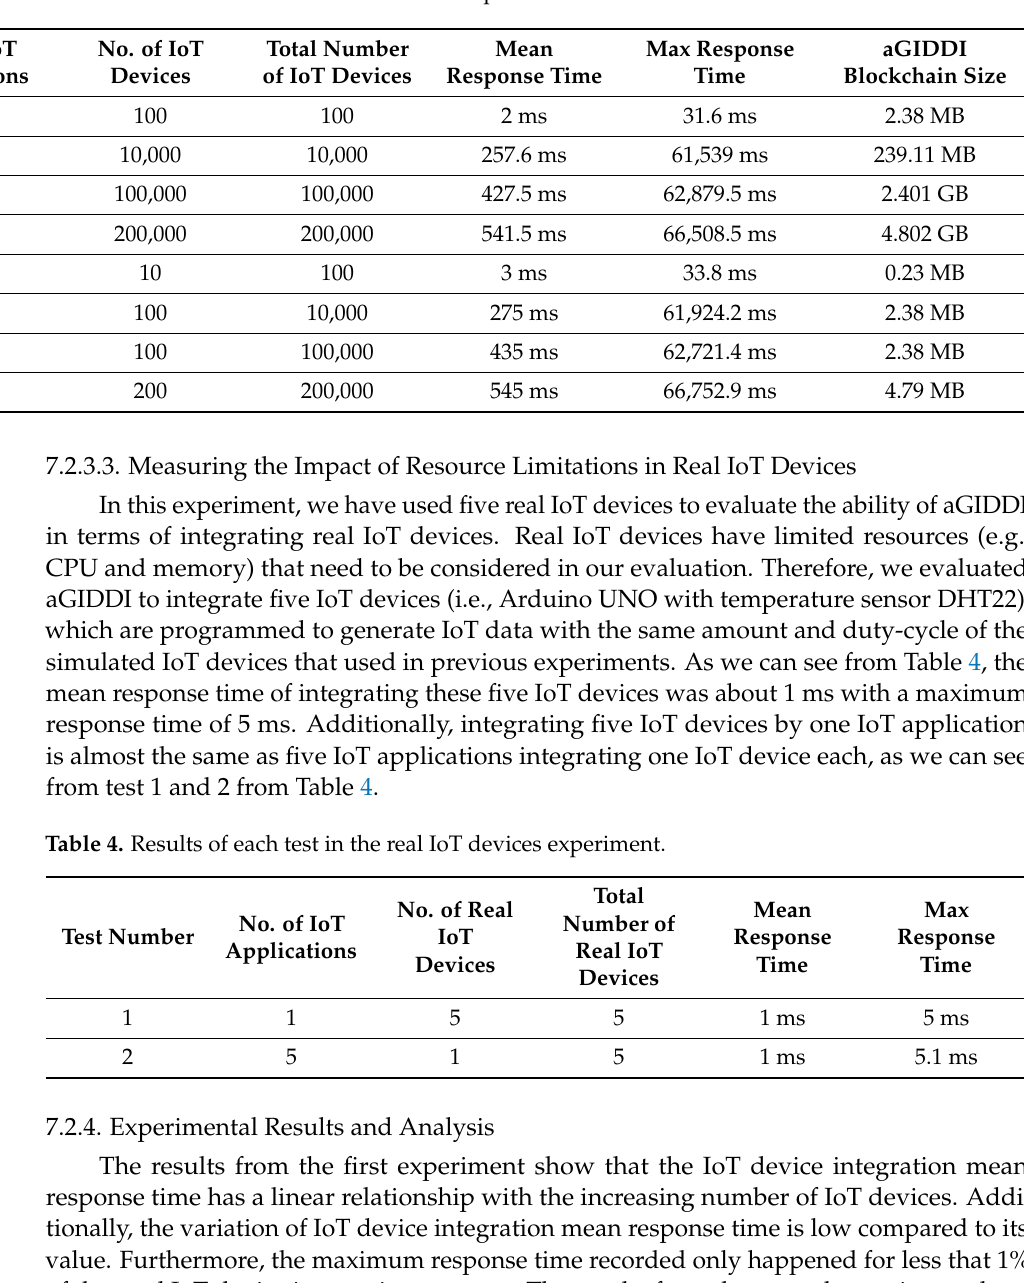
Table 3. Results of each test in the second experiment.